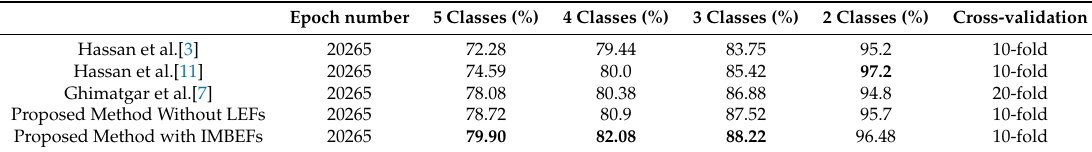
Table 31. The accuracy comparison of various published methods on the Dreams Subjects database under the AASM standard. Highest accuracy in each case is highlighted in bold.